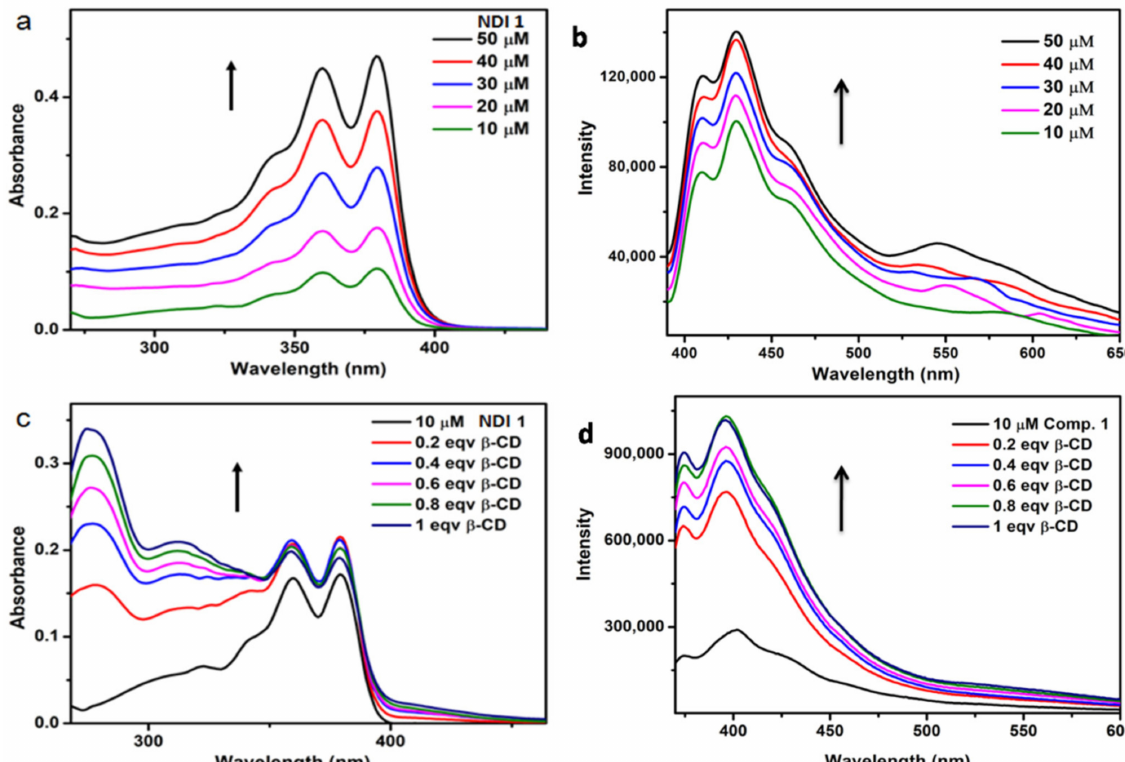
Figure 5. ( a )Absorption spectra of NDI 1 in DMF with increasing concentration; ( b ) The emission spectra of NDI 1 in DMF with increasing concentration, excitation at 380 nm;( c ) Absorption spectra of NDI 1 in DMF with the gradual addition of β -CD; ( d ) The emission spectra of NDI 1 in DMF with the gradual addition of β -CD, excitation at 360